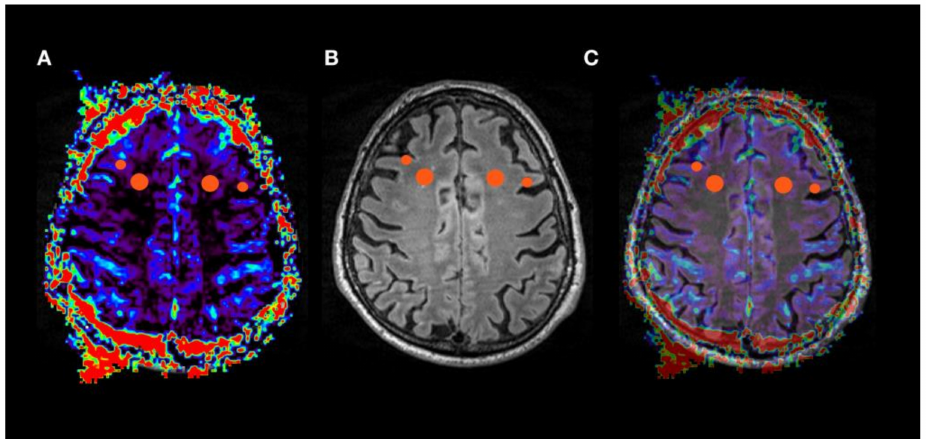
Figure 1. ROIs in rBV (relative cerebral blood volume) map (oSVD - oscillation-index standard truncated singular value decomposition). Circular ROIs were placed in cortex and white matter in frontal lobe ( A – C ), as well as in parietal and temporal lobe and in hippocampus in the respective hemodynamic parameter maps rBV ( A ), rBVc (relative cerebral blood volume corrected), rBF (relative cerebral blood flow) and MTT (mean transit time) both for oSVD and Bayesian deconvolution. Data sets were coregistered with an anatomical dataset ( B , T2 SPACE) and fused ( C ) for correct placement of